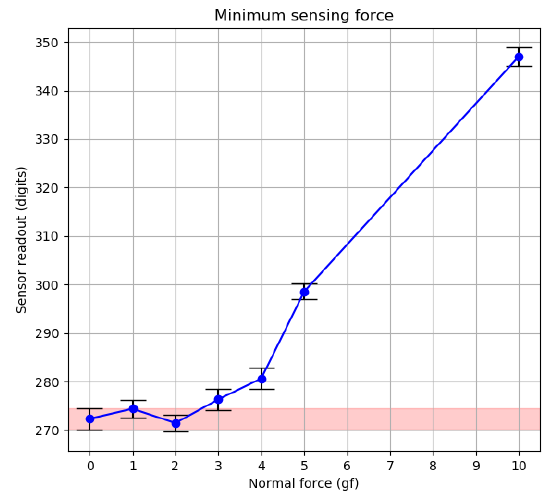
Figure 15. Minimum detectable normal force experiment